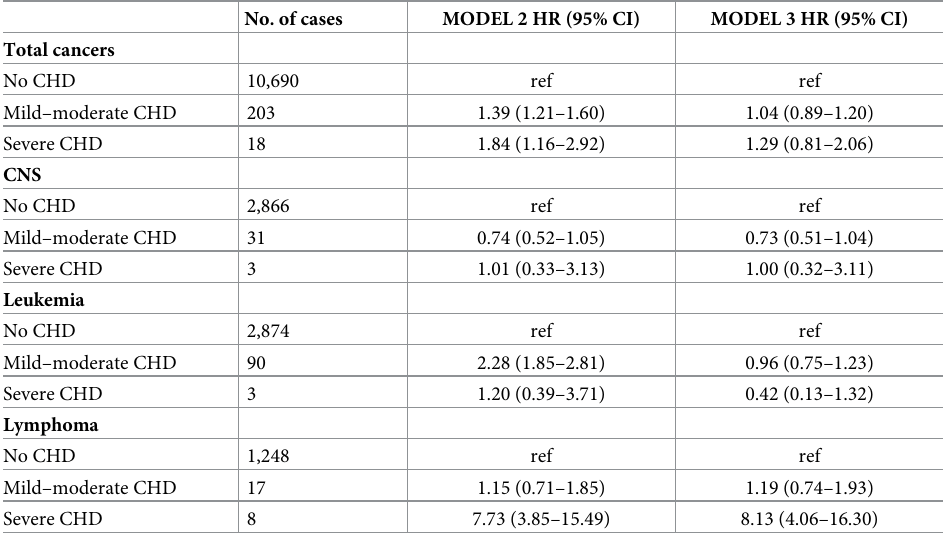
Table 3. Adjusted HRs (95% CIs) of cancer in children by CHD complexity.